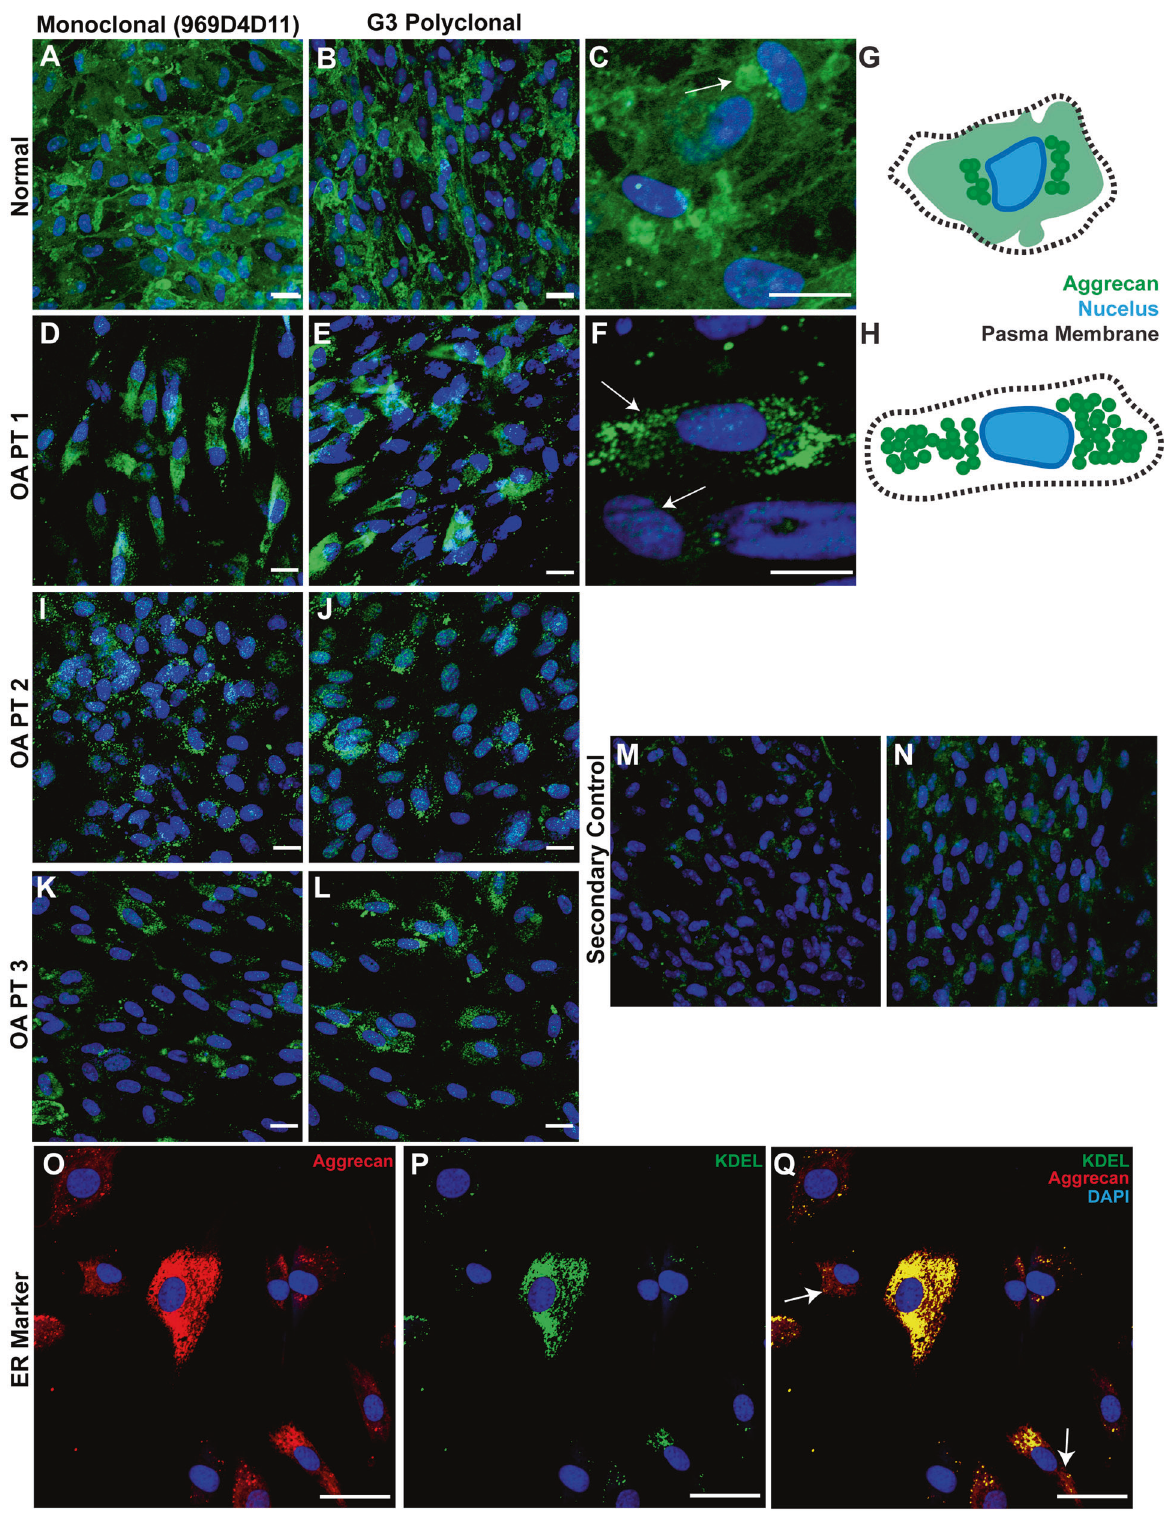
Fig. 1 Aggrecan localization in normal and OA synovial MPCs. In normal synovial MPCs, aggrecan staining is present throughout the cytoplasm ( A – C ), with areas of increased staining observed adjacent to the nucleus ( C , arrow, G — representation). In OA synovial MPCs, little to no cytoplasmic staining is observed ( D – L ), instead intense staining is observed only adjacent to the nucleus ( F , arrows, H — representation). When OA MPCs were doubled labeled for aggrecan (G3 polyclonal) ( O ) and a marker of the endoplasmic reticulum (KDEL, P ), the majority, but not all of the aggrecan staining appeared to be within the endoplasmic reticulum ( Q , arrows). Secondary antibody alone controls demonstrate minimal non-speci fi c staining ( M , N ). Scale bars equal 10 µm ( A – L ), 20 µm ( O – Q ).